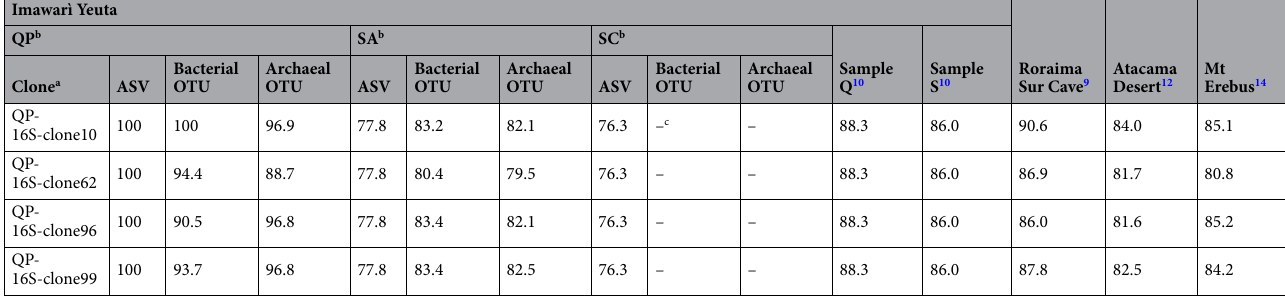
Table 1. Comparison between the QP Ktedonobacterales 16S rRNA clone sequences, the ASV and OTU sequences from the Imawarì Yeuta samples and the Chloroflexi -related sequences retrieved from other quartzite environments. Nucleotide sequence identity (expressed in %) was calculated by using Blast algorithm. Numbers in apex correspond to the references. a Representative clones from the 16S rRNA clone library of QP that were Sanger sequenced. b Sequencing data obtained in this work. c “–” indicates the absence of OTUs affiliated to Chloroflexi in the corresponding